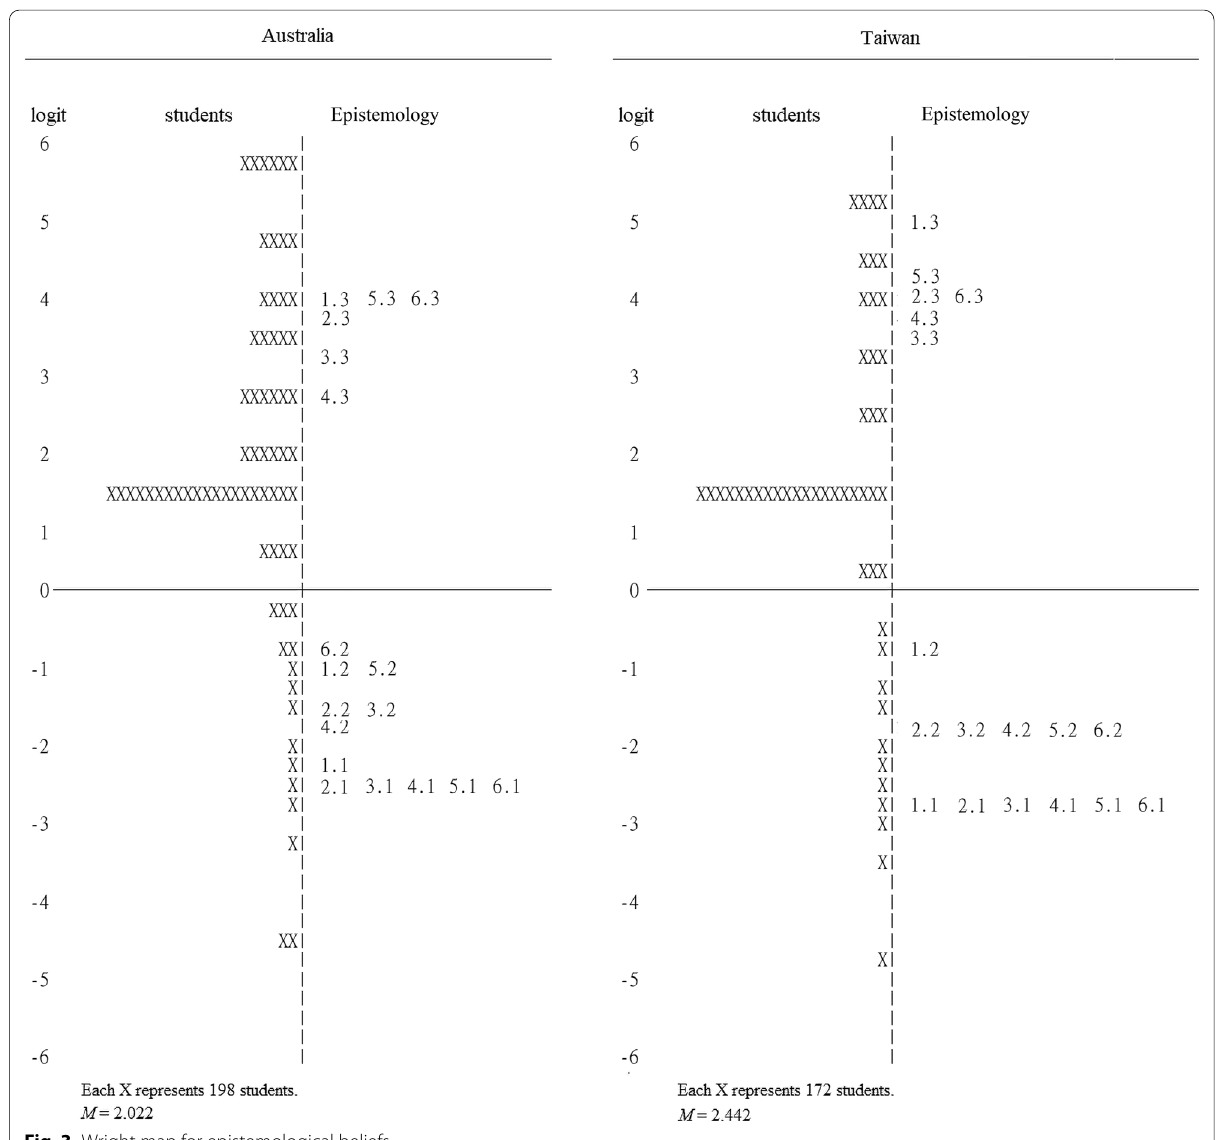
Fig. 3 Wright map for epistemological beliefs